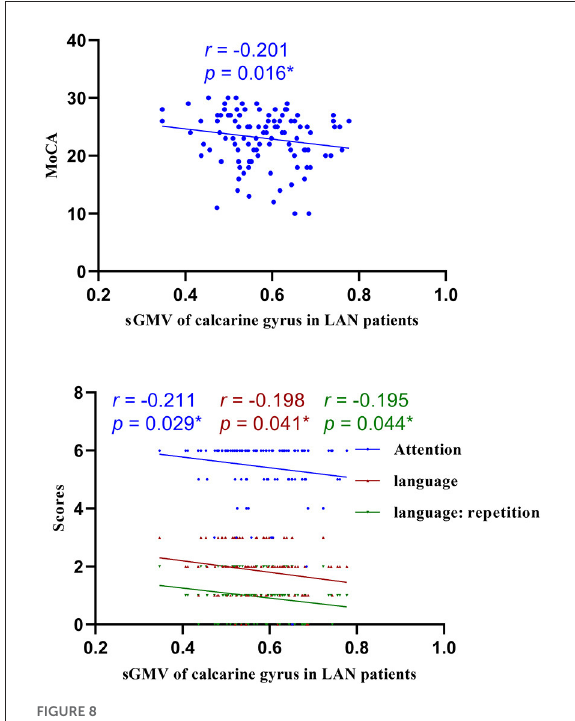
FIGURE8 Correlations of sGMV of calcarine gyrus and MoCA in LAN patients. LAN, left acoustic neuroma; sGMV, smoothed gray matter volume. * p < 0.05.